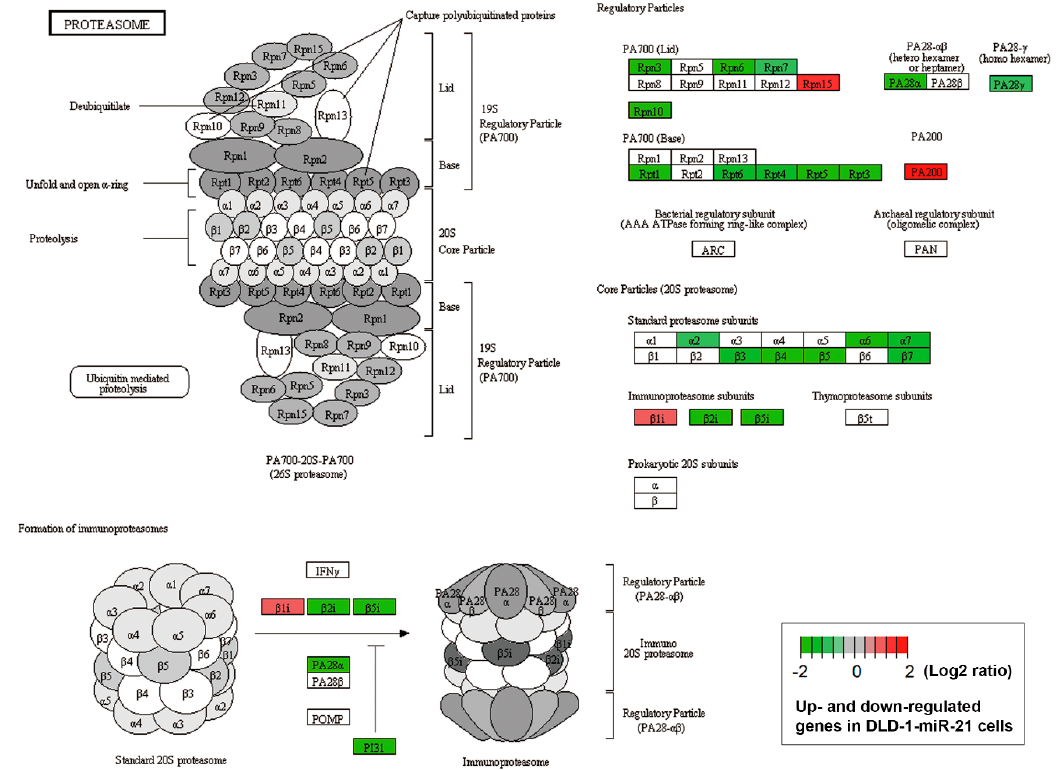
Figure 5. Proteasome pathway mapping of altered genes in DLD-1-miR-21 cells. A Kyoto Encyclopedia of Genes and Genomes (KEGG) pathway enrichment analysis was performed as described in “Materials and Methods”. Differentially expressed genes (DEGs) in DLD-1-miR-21 cells were mapped to the KEGG proteasome pathway (hsa03050). The genes highlighted in red and green indicated the upregulated and downregulated genes in DLD-1-miR-21 cells. The original data are shown in Table S2.